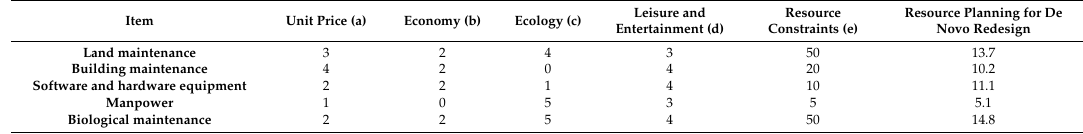
Table 8. Planning and restraint of